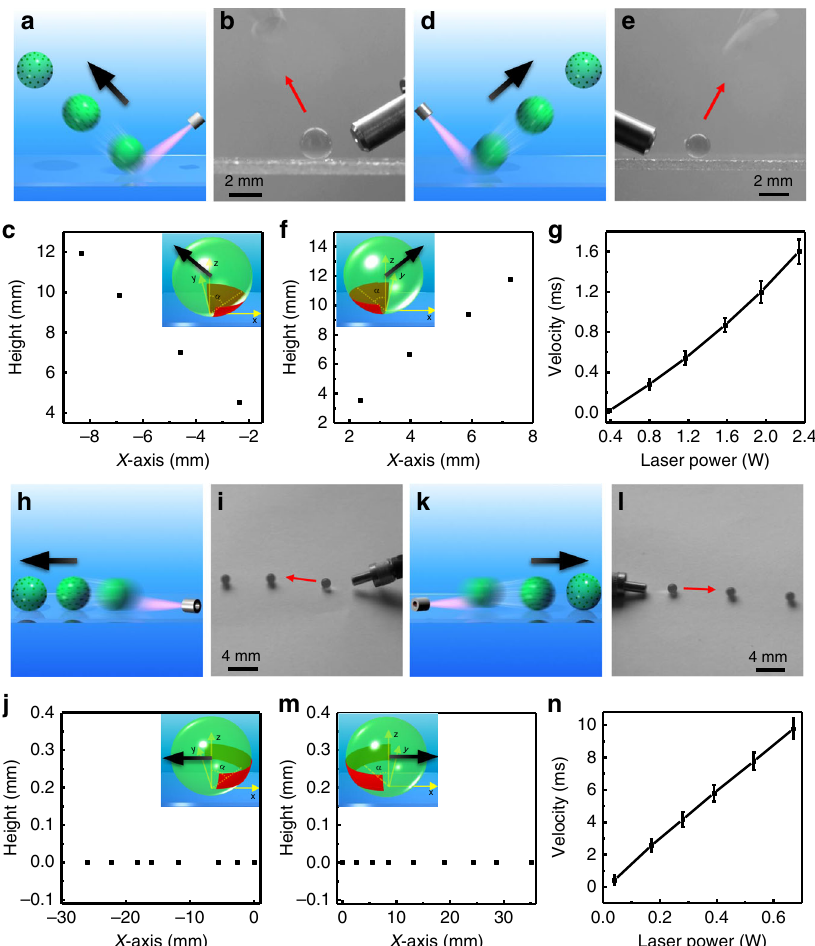
Fig. 3 The motion control of the light-driven in-air hydrogel actuator. Schematics, overlaid CCD camera images and moving trajectories indicating the motion of the hydrogel actuator, i.e., jumping to a – c left and d – f right under 2.34 W irradiation, rolling to h – j left and k – m right under 0.67 W irradiation, which are controlled by light irradiation position. Inset: Schematics illustrate the irradiated position (red area) in case of different motion behaviors. The laser power dependent jumping and rolling velocities are shown in g and n , respectively. The images in b , e , i , and l are captured from Supplementary Movies 8 – 11, respectively. Note that the left rolling or jumping distance is de fi ned as negative. Error bars denote the standard